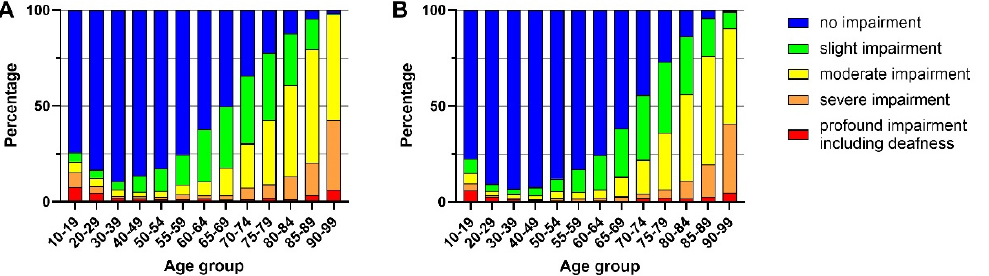
Figure 4. Percentage of participants in each hearing-loss severity, in the five WHO grades [18]. ( A ) Males; ( B ) females.